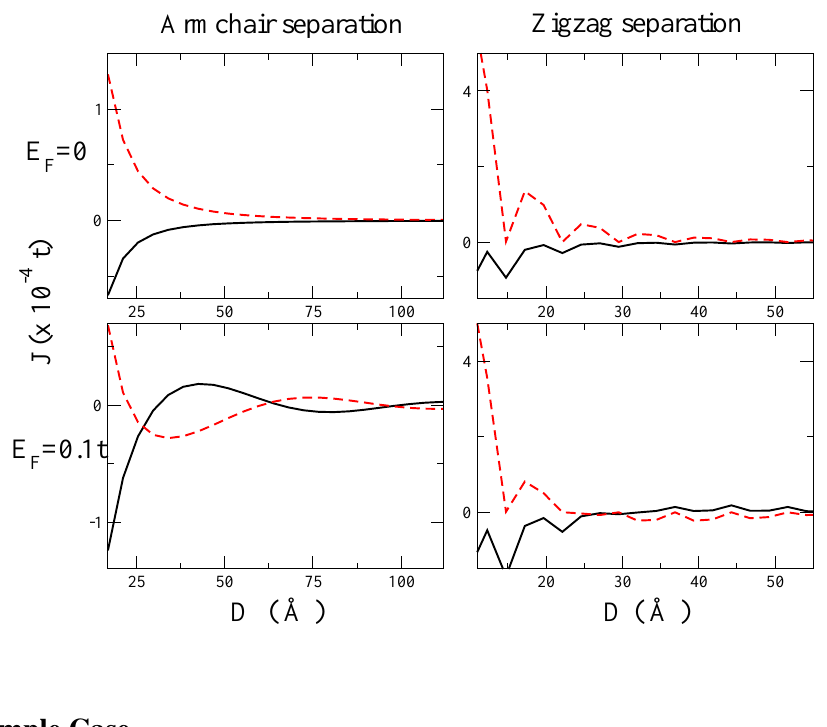
Figure 4. The indirect exchange coupling between two moments separated in the armchair (direction) are shown in the left (right) panel as a function of moment separation. Results for the undoped (doped) case are shown in the top (bottom) panels. Results are shown for both the same sublattice (black, solid lines) and opposite sublattice (red, dashed lines)